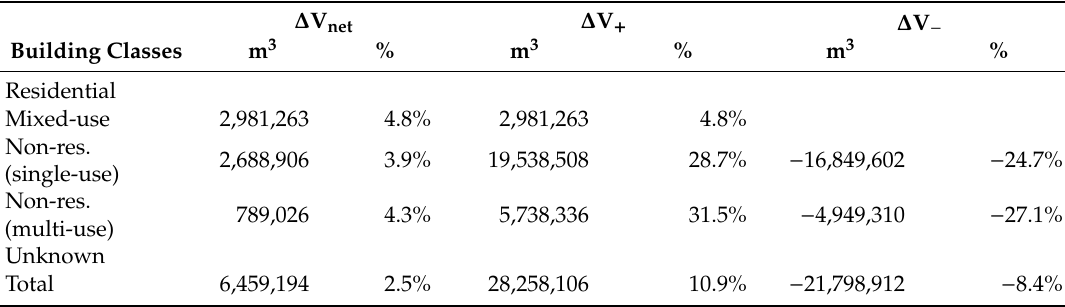
Table 3. Aggregated volume di ff erences between UsageZones (from the Functiekaart) buildings (from the city model) per building